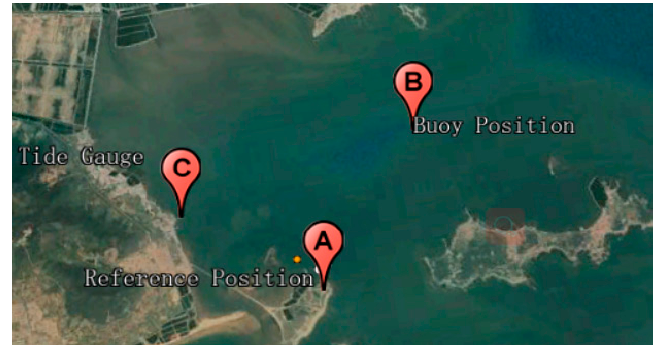
Figure 9. The location of study area near Qingdao, China. A is the fixed reference GPS station, B is the multi-function buoy, and C is the long-term tide gauge station.